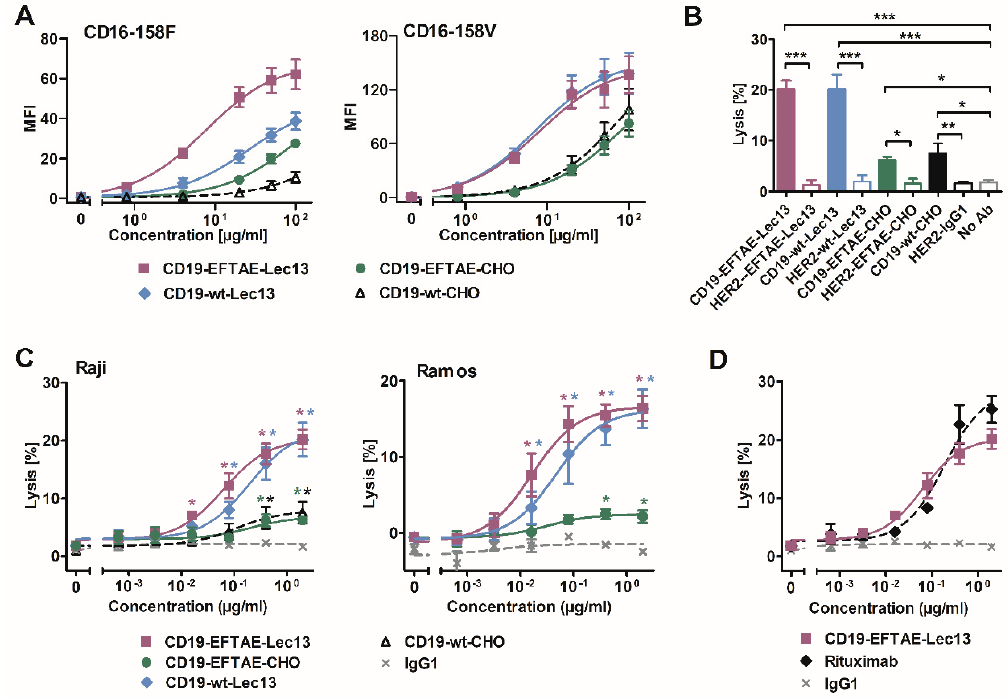
Figure 3. Fc γ RIIIA binding and induction of ADCC by di ff erentially engineered CD19 antibodies. ( A ) Binding of antibodies CD19-wt-CHO, CD19-EFTAE-CHO, CD19-wt-Lec13 and CD19-EFTAE-Lec13 to transfected BHK cells stably expressing human Fc γ RIIIA-158V (BHK-CD16-158V) or Fc γ RIIIA-158F (BHK-CD16-158F) alleles was analyzed by flow cytometry. Secondary FITC-coupled anti-human IgG Fc F(ab’)2 fragments were employed for detection. MFI, mean fluorescence intensity. ( B ) Induction of ADCC by antibody versions (concentration: 2 µ g / mL) was investigated in 51Cr release experiments using Raji as target cells and human MNC as e ff ector cells. Similarly designed variants of trastuzumab were used as controls. Bars represent mean values of specific lysis ± SEM. Significant di ff erences between CD19 antibodies and HER2-specific control antibodies or the control reaction performed in the absence of any added antibody (no Ab) are indicated (*, p ≤ 0.05; **, p ≤ 0.01; ***, p ≤ 0.001 n = 3). ( C ) Dose-dependent induction of ADCC by CD19 variants was analyzed using Raji ( n = 3) or Ramos cells as targets and MNC as e ff ector cells. Data points indicate mean values of specific lysis ± SEM. Statistically significant di ff erences in ADCC between CD19 antibodies and the control antibody trastuzumab (IgG1) are indicated (*, p ≤ 0.05; **, p ≤ 0.01; n = 3). ( D ) Comparison of ADCC by the Fc double-engineered antibody CD19-EFTAE-Lec13 (purple) and by the CD20 antibody rituximab (black). Trastuzumab served as an additional negative control (IgG1). Raji cells were used as target cells and MNC served as effector cells. Mean values of specific lysis ± SEM are shown ( n = 3).